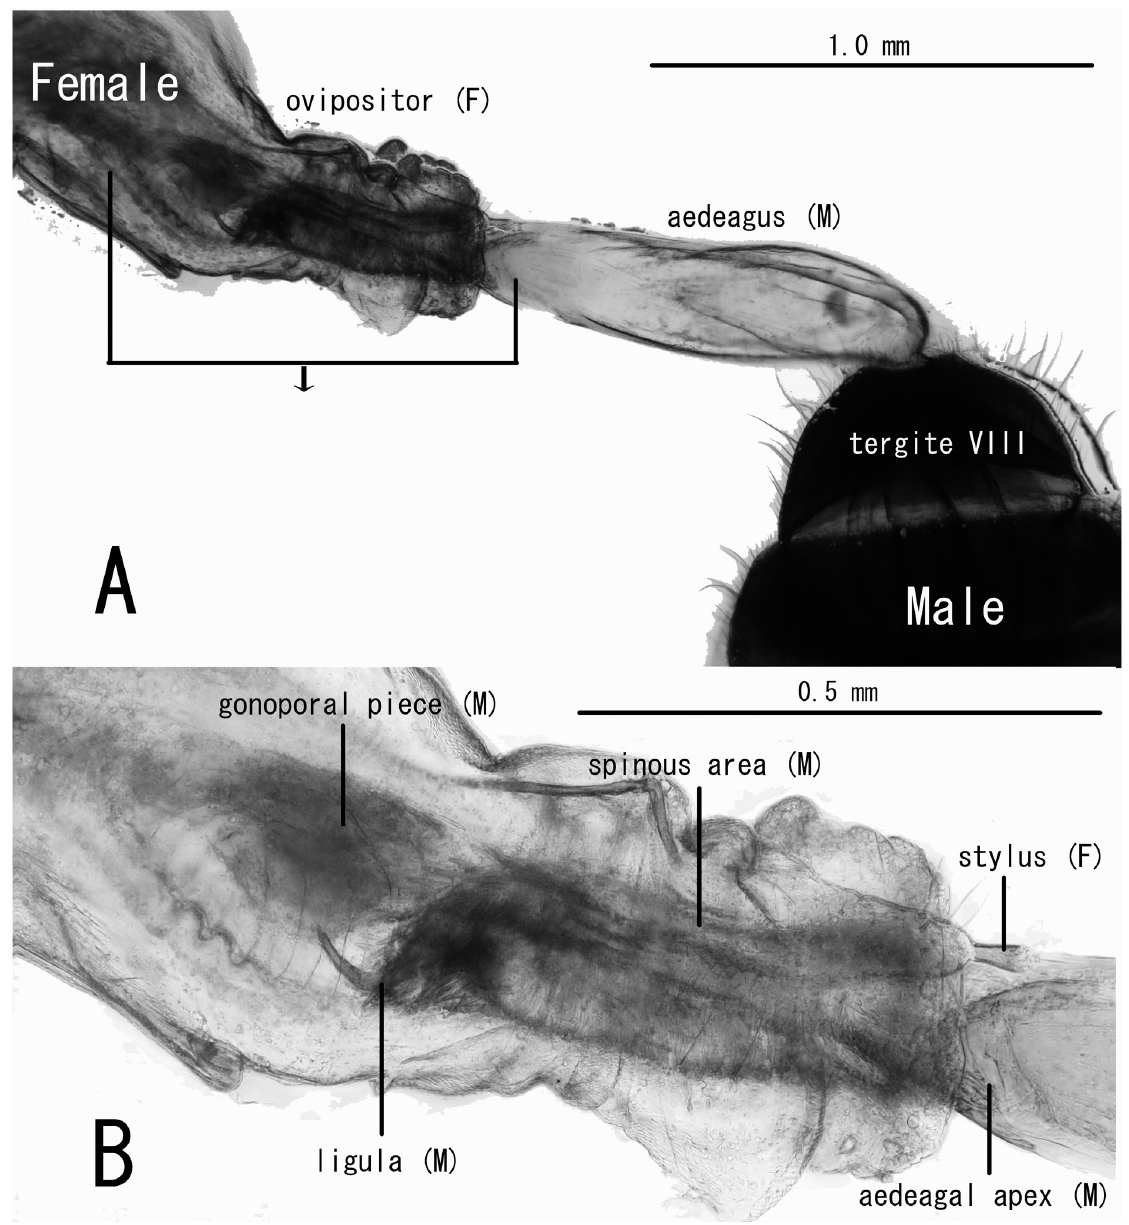
Fig. 1. Copulation of Laius baliensis sp. nov. A . Endophallus fully engaged with female structures in dorsal view. B . Endophallus fully engaged with female structures in dorsal view, close up. Abbreviations: M = male, F =